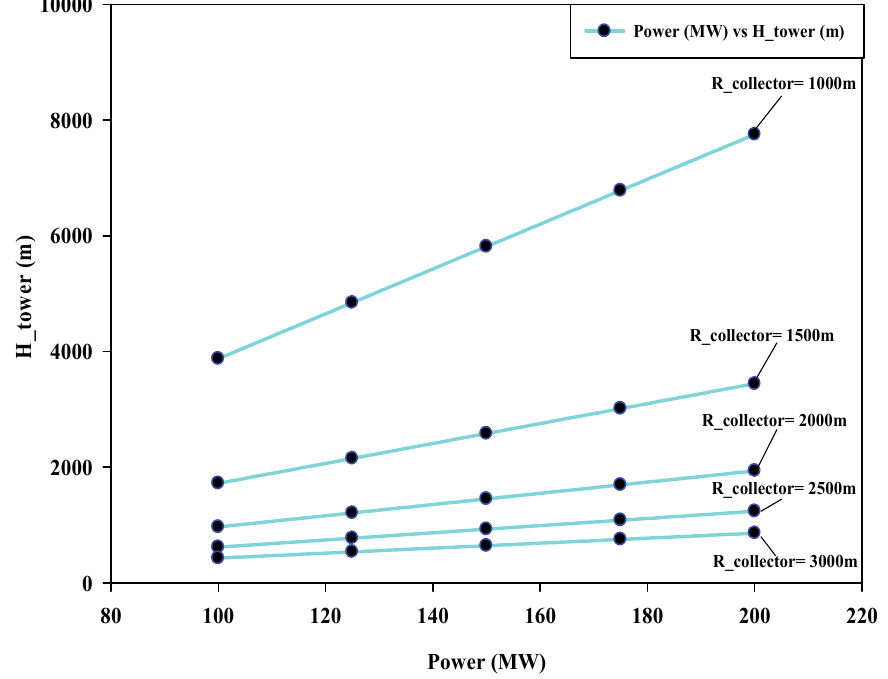
Figure 17. Effect of variation in power output on tower height ( H Tower ) for different collector radii ( R Collector ) in SUTPP.